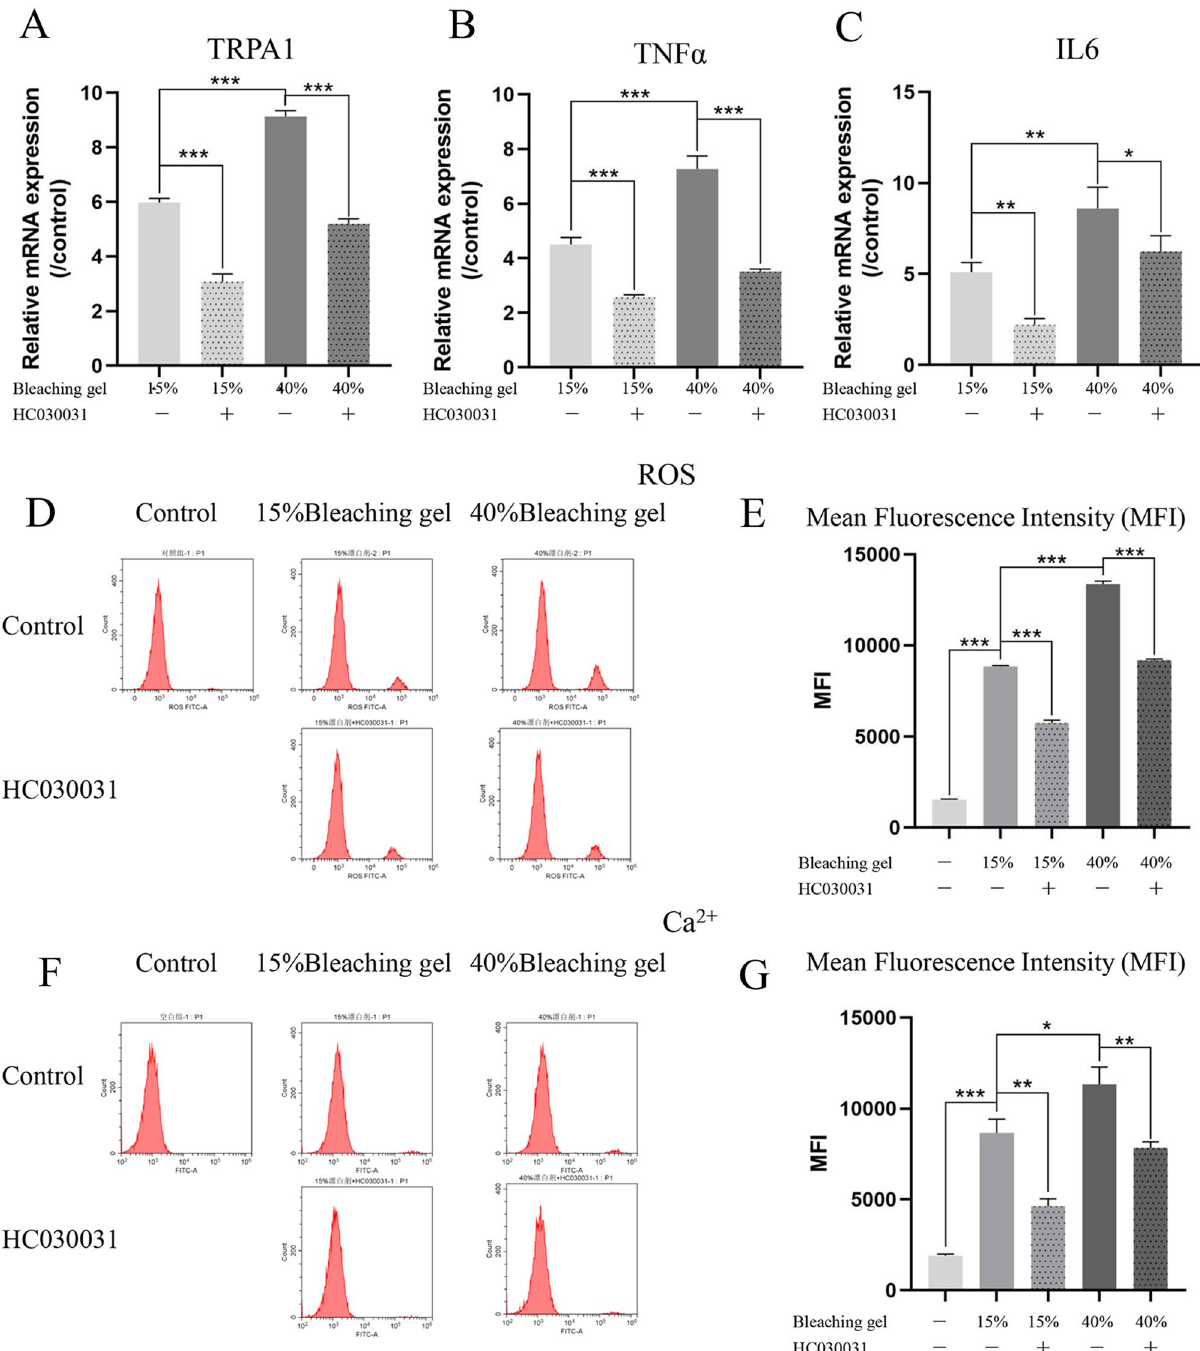
Figure 2. TRPA1triggers inflammation, oxidative stress, and Ca 2+ influx in DPSCsafter bleaching. RT-PCR for TRPA1 ( A , Ca 2+ influx channel), TNFα ( B ), and IL6 ( C ) expression. Bleaching gel induced upregulation of these genes in a dose-dependent manner, whereas HC030031 (TRPA1 inhibitor) reduced this effect. Fluorescence staining and flow cytometry showed that the changes in intracellular ROS ( D and E ) and Ca 2+ ( F and G ) were the same as those in TRPA1 mRNA. Data are presented as the mean ± SD, * P < 0.05 , ** P < 0.01 , *** P < 0.001 , Student’s t- tests. TRPA1, transient receptor potential ankyrin 1; DPSCs, dental pulp stem cells; RT-PCR, reverse transcription-polymerase chain reaction; ROS, reactive oxygen species; MFI, mean fluorescence